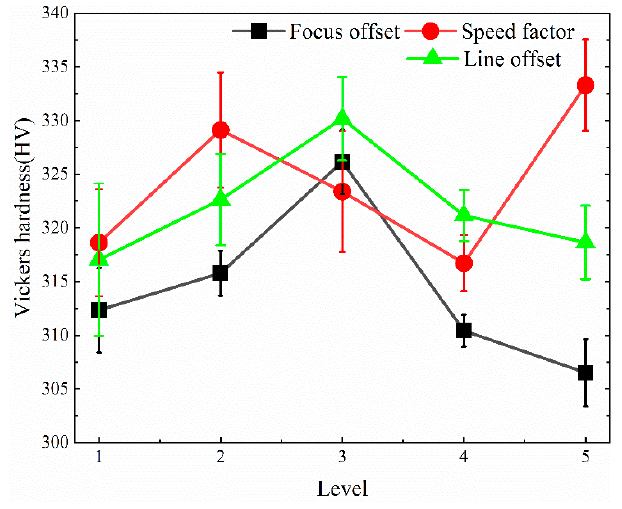
Figure 16. Effect of various factors on the Vickers hardness of Ti-6Al-4V samples. Figure 16. E ff ect of various factors on the Vickers hardness of Ti-6Al-4V